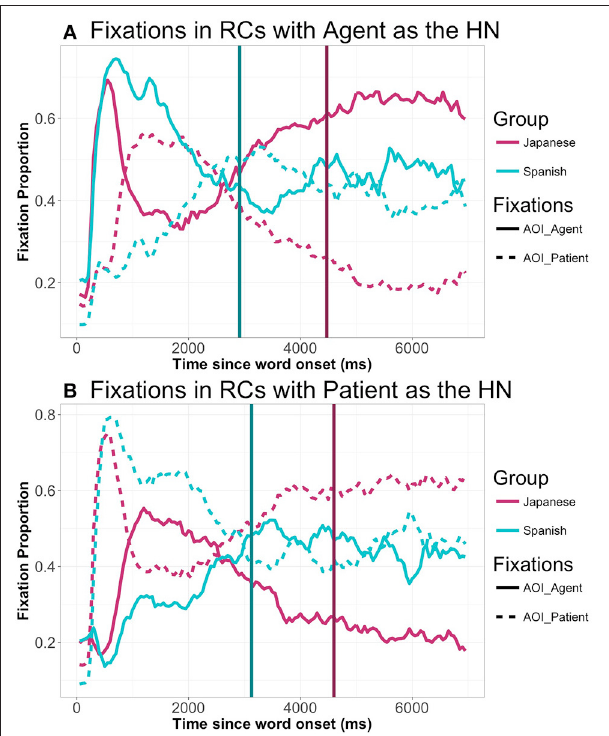
FIGURE 5 | General gaze patterns to agent and patient in Spanish and Japanese RCs with the agent as HN (A) and with the patient as HN (B) (all animacy combinations collapsed): From picture onset until 7,000ms. Vertical lines represents speech onset in either language.